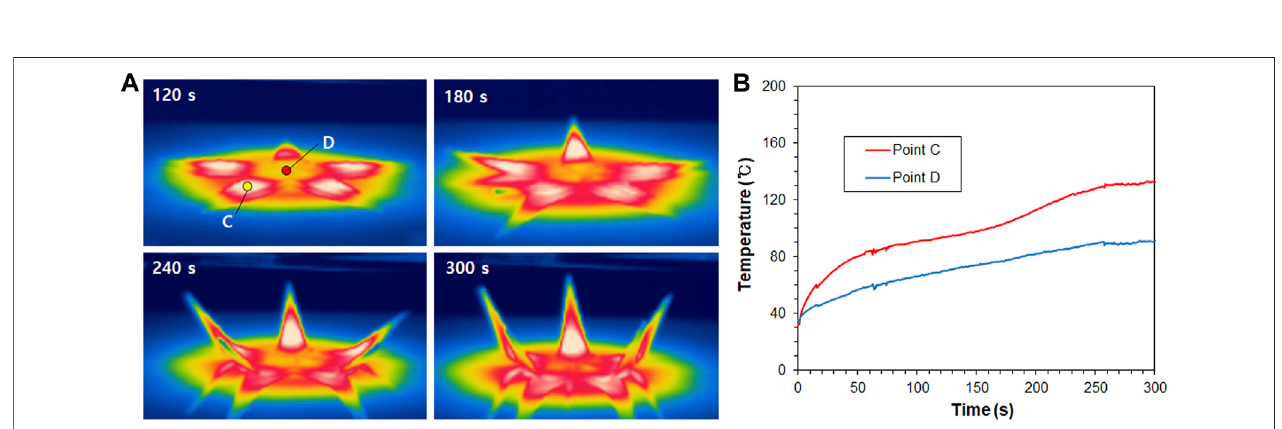
FIGURE8| Localshapetransformationofthe2Dstar-shapeplate (A) Deformationsandtherelevanttemperaturechanges (B) Comparisonoftemperaturepro fi les at points C and D.